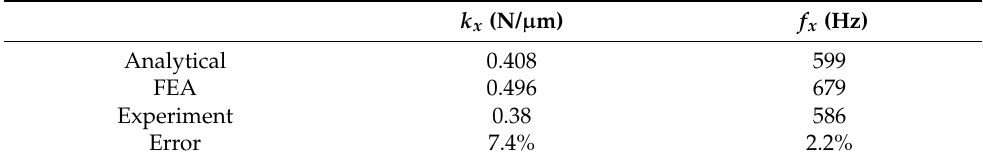
Table 1. Performance comparison of the mechanism.